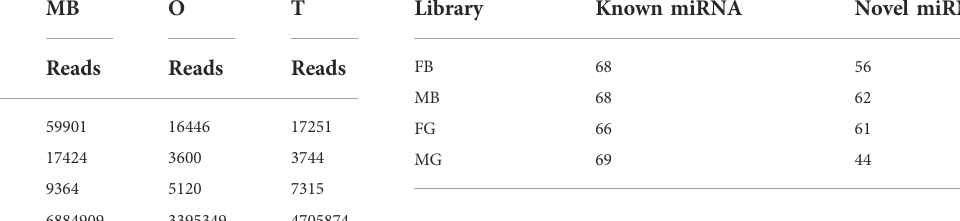
TABLE 1 Reads distribution of four small RNA libraries. Note: FB, female brain; MB, male brain; O, ovary; T, testis. Category